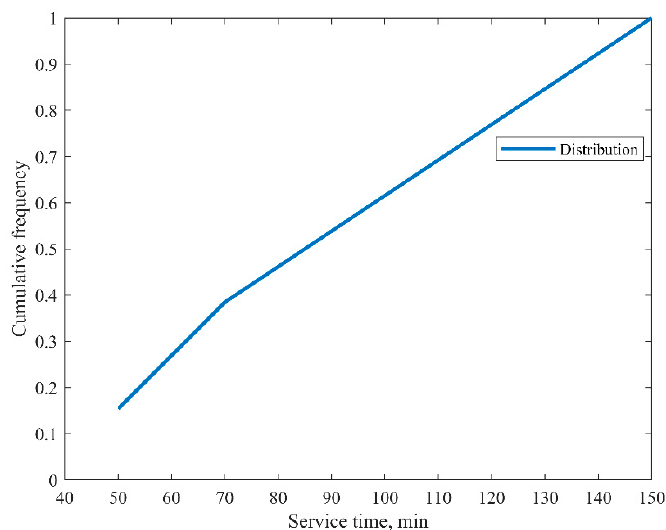
Figure A3. Service time distribution of the turnaround process.